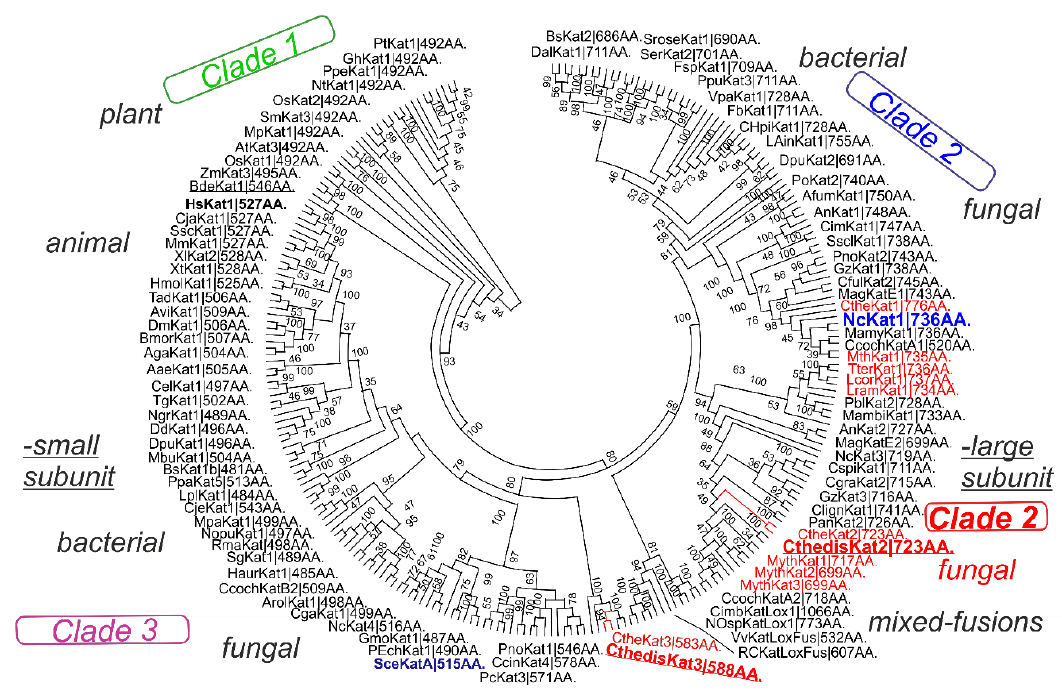
Figure 6. Global phylogenetic tree of 250 heme catalases obtained with the maximum likelihood method of MEGA-X package [15] by using Le Gascuel model of substitutions. A discrete Gamma distribution to model evolutionary rate difference, partial deletion with 33% site coverage, and 100 bootstrap replications were used in this reconstruction. Only bootstrap values above 30 are shown. There were in total 694 positions used in the final dataset. Sequences from thermophiles are labeled in red. Abbreviations of used sequences are explained in Table S4. Antioxidants 2020 , 9 , x FOR PEER REVIEW